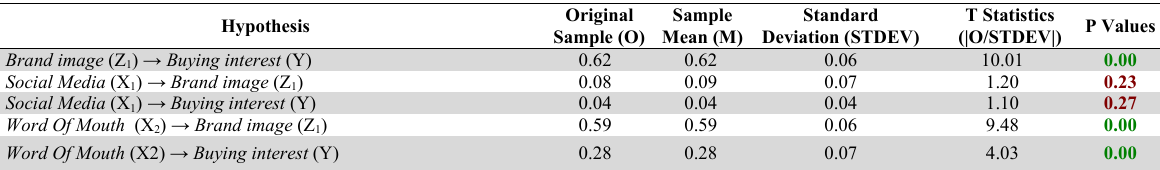
T-statistics and Direct P-Values